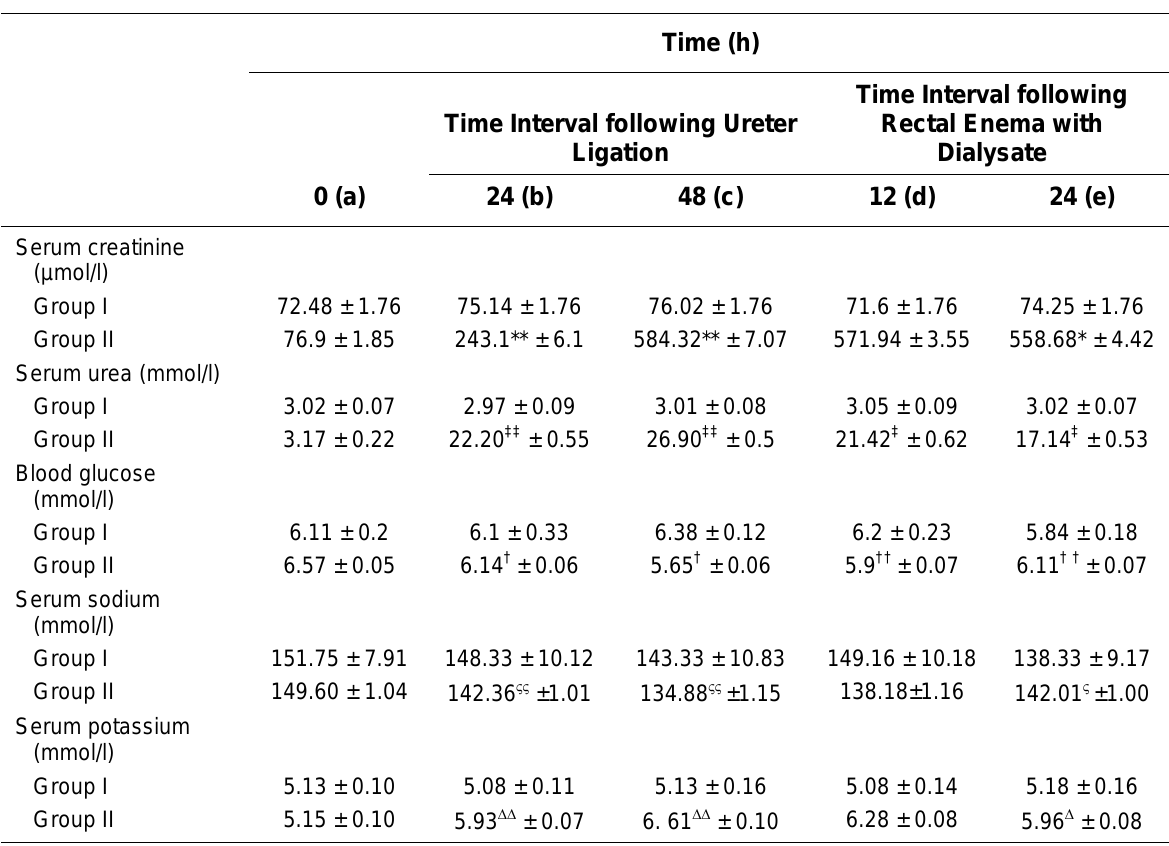
Serum Creatinine (µmol/l), Urea (mmol/l), Glucose (mmol/l), Potassium and Sodium (mmol/l) Level at Different Times in Dogs following Ureter Ligation and Rectal Enema with Dialysate (Values are Mean with SE of Six